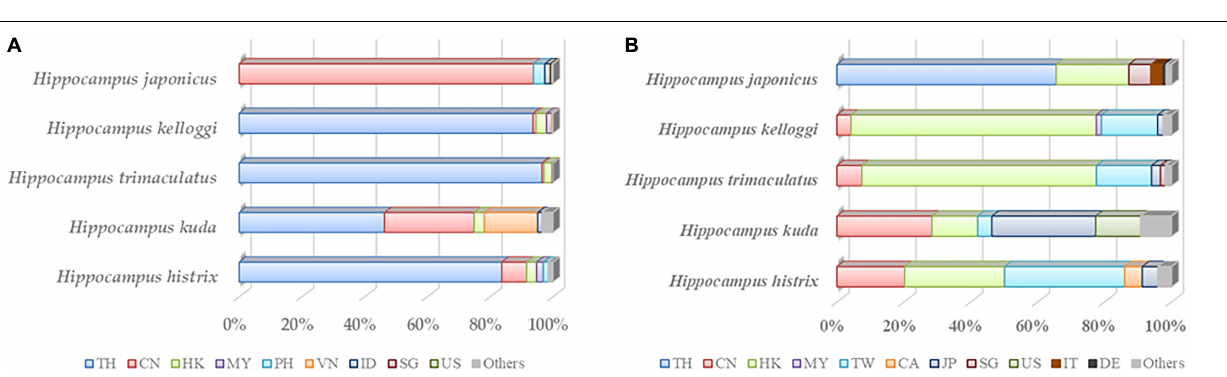
FIGURE 2 | (A) The top 10 countries of Hippocampus species; (B) The species of Hippocampus in each continent.